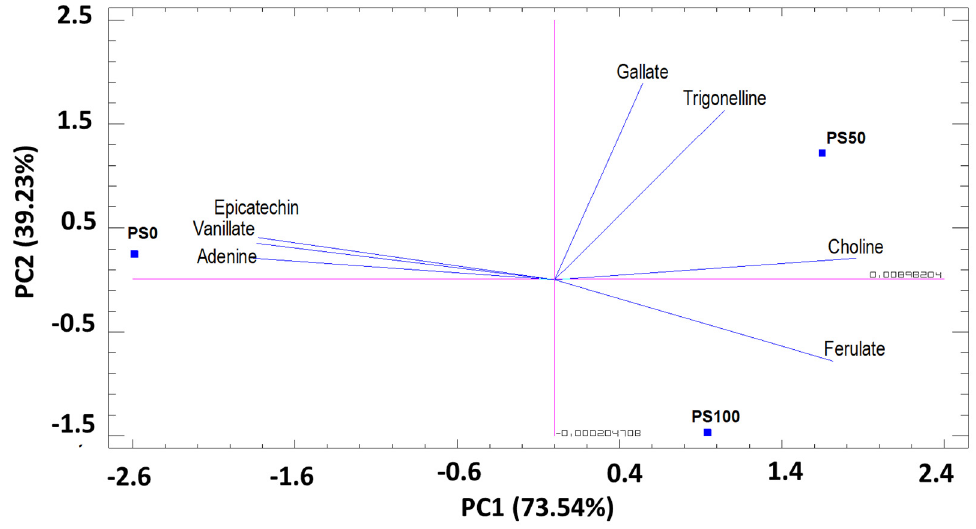
Figure 3. Principal components analysis (PC1 and PC2) for secondary metabolites identified in pomegranate leaves cultivated in three different substrates. PC1 (73.54%) and PC2 (26.46%).